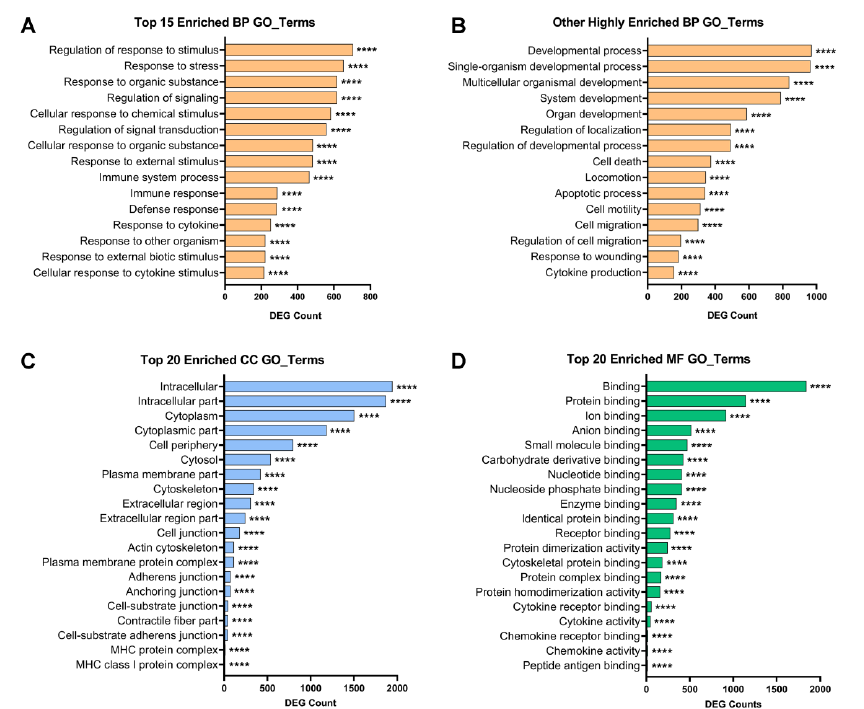
Figure 3. Gene Ontology analysis. Summary of significantly enriched biological annotations with DEG resulting from the comparison M1vsD10. The x -axis shows the amount of DEG annotated with each given GO term and the y -axis shows the list of GO terms. ( A ) Top 15 of most significantly enriched (lowest p (adj)) biological process GO annotations. The common theme is response to inflammation and stress events. ( B ) Other 15 biological process GO annotations with high DEG enrichment that reflect an increased reparative potential of conditioned MSCs, while viability and motility seem to be compromised. ( C ) Top 20 of most significantly enriched cellular component GO annotations, indicating the high level of activity in the cytoplasmic and peripheral regions. ( D ) Top 20 of most significantly enriched molecular function GO annotations, indicating high transcriptomic regulation, intracellular trafficking, and signal transduction. Asterisks represent the statistical value based on the corrected p -value resulting from the hypergeometric test (**** indicates p (adj) < 0.0005). Abbreviations : GO: gene ontology; BP: biological process; CC: cellular component; MF: molecular function; DEG: differentially expressed